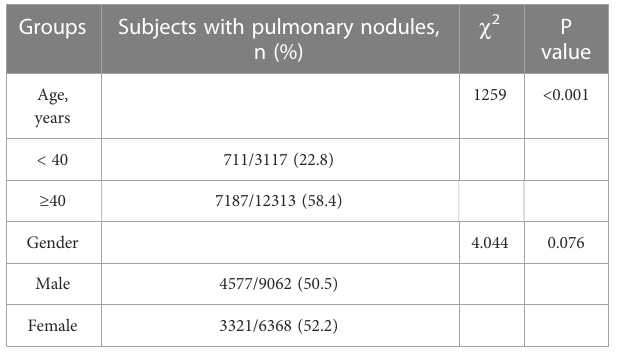
The sensitivities of each TAAB in the panel for detecting lung cancer varied greatly, ranging from 3.85% to 34.6%. Notably, GBU4-5 was found to be the most sensitive, with a positive rate of 34.6% in diagnosed patients, while MAGEA1 and CAGE exhibited the lowest sensitivities at 3.85%. The patient group showed speci fi c positivity for SOX2, GAGE7, GBU4-5, and MAGEA1, while P53, PGP9.5, and CAGE sporadically showed positivity in the healthy controls (Table 3, Figure 1).